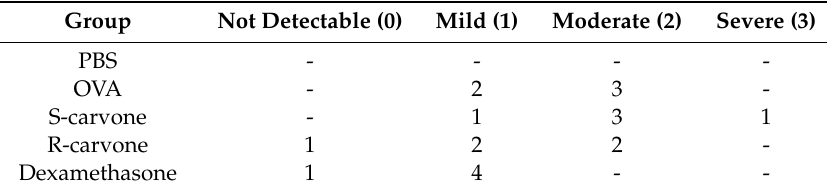
Figure 4. Effects of carvone enantiomers on mucus production in the lung of allergic mice following OVA-induced allergic airway inflammation. ( A ) Photomicrographs of lungs stained with periodic acid from Schiff (PAS). ( B ) The mucus production index on PAS-stained slides was determined using the Image J software and expressed as means ± SEM from five animals. + significant difference ( p < 0.05) from the unchallenged group; *** ( p < 0.001) express significant difference from the untreated OVA-challenged group. Statistical significance was determined with one-way ANOVA and post hoc Tukey test. Twenty-four hours after the last challenge, lungs were fixed in 10% formalin, embedded in paraffin and sectioned. The tissue section slides were stained with PAS. OVA-sensitized mice were treated with R-carvone (10 mg / Kg), S-carvone (10 mg / Kg), dexamethasone (1 mg / Kg) or PBS (vehicle) 1 h prior to each challenge. These analyses were performed by a blind observer using a light microscope with 100 × magnifications. Each photomicrograph is representative of two independent experiments performed with five animals per group. Table 2. Mucus production score per experimental group ( n =